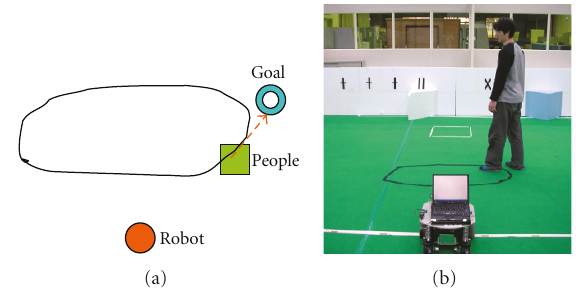
Figure 8: Object tracking experiment. (a) People trajectory. (b) Experimental environment. Table 1: Comparisons of errors in cm of KF, PF, and RBPF using stream field-based tracking algorithms. KF PF RBPF-SF Total error mean 11.3